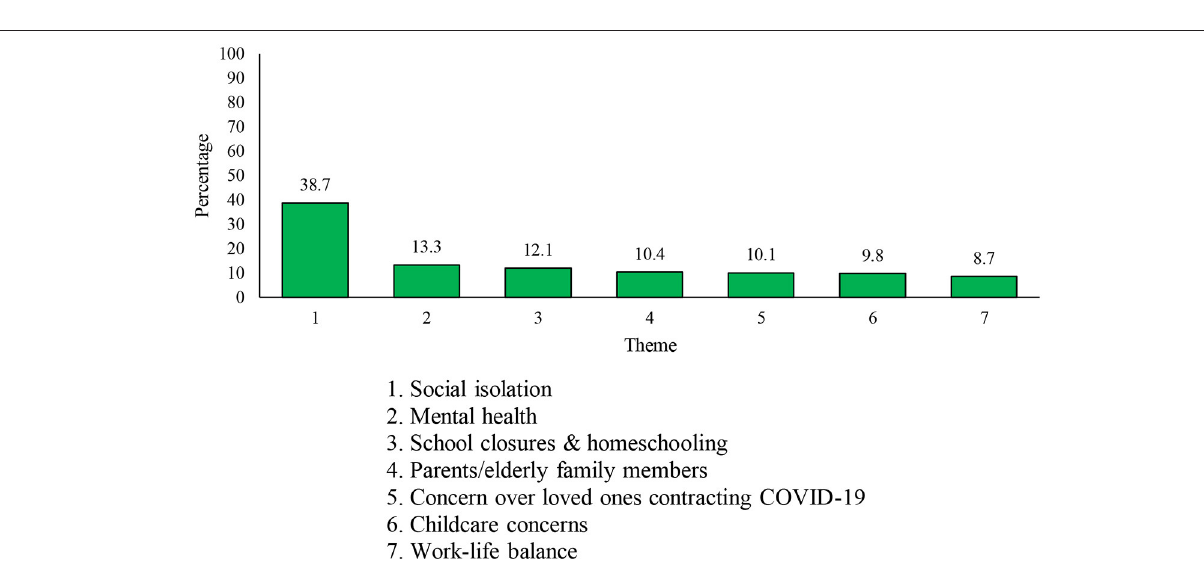
FIGURE 3 | Seven most frequently mentioned personal and family-related